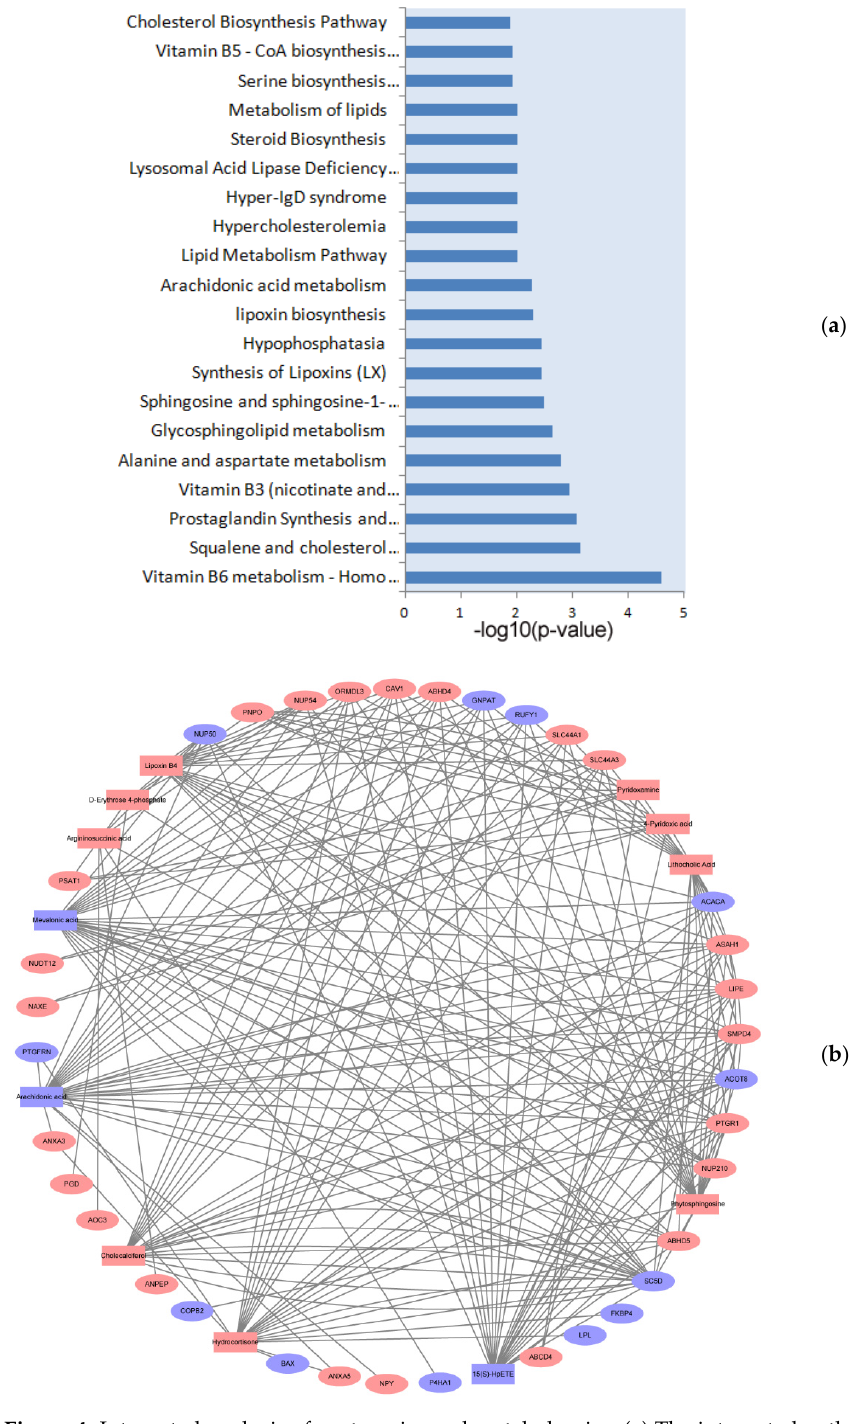
Figure 4. Integrated analysis of proteomics and metabolomics. ( a ) The integrated pathways analysis results of proteomics and metabolomics, only showing the top 20 pathways ( p < 0.05). ( b ) We chose the pathways as an intermediate carrier, and the proteins and metabolites network were obtained. The circle represents proteins, and the triangle represents metabolites. Red represents the upregulated molecule, and blue represents the downregulated molecule. The line number indicates that proteins and metabolites are involved in multiple pathways. High-fat diet: HFD and restricted diet: